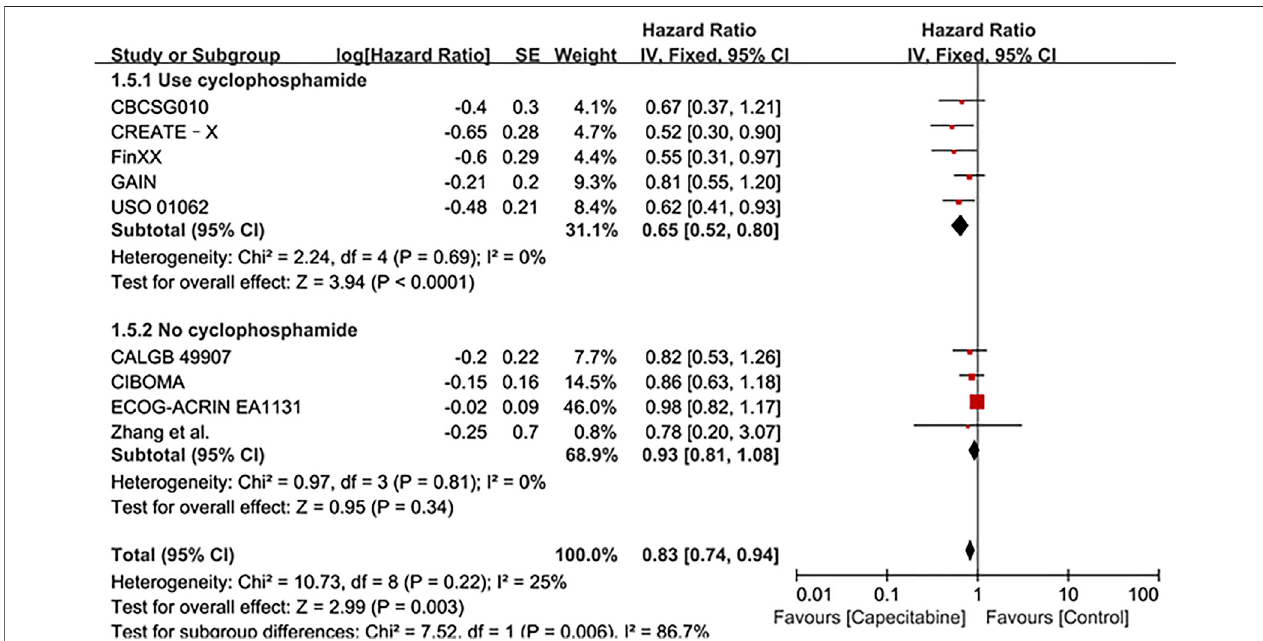
FIGURE 6 | Subgroup analysis of the effect of capecitabine and cyclophosphamide combined with chemotherapy on OS in TNBC patients.